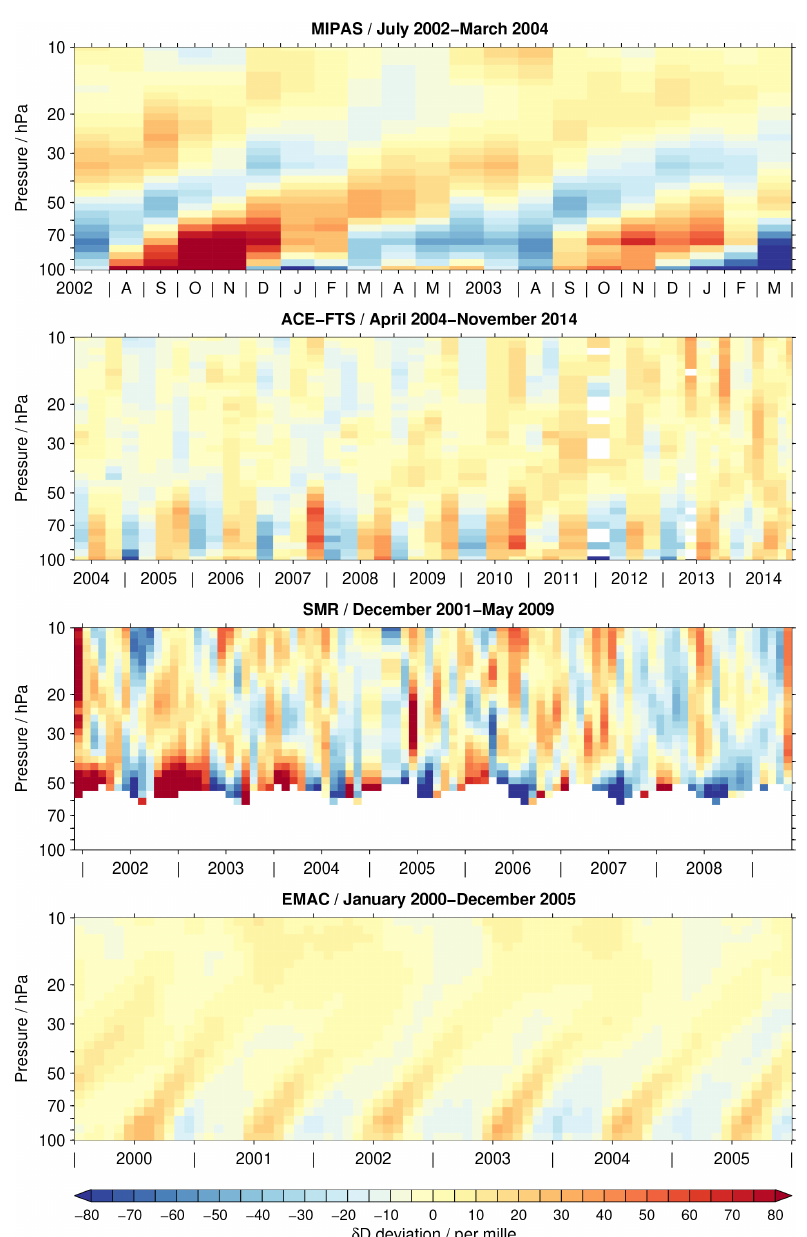
Figure 1. Tropical time series of δ D deviations from the annual mean covering the altitude range between 100 and 10hPa. Depending on the data set, a different time period is covered, which is indicated in the individual panel titles. For the EMAC simulation, the time period from 2000 to 2005 is considered arbitrarily. Observational gaps in the data sets are removed for better visibility, in particular for the ACE-FTS data set. A figure without the gap removal is included in the Supplement. White areas indicate that no data are